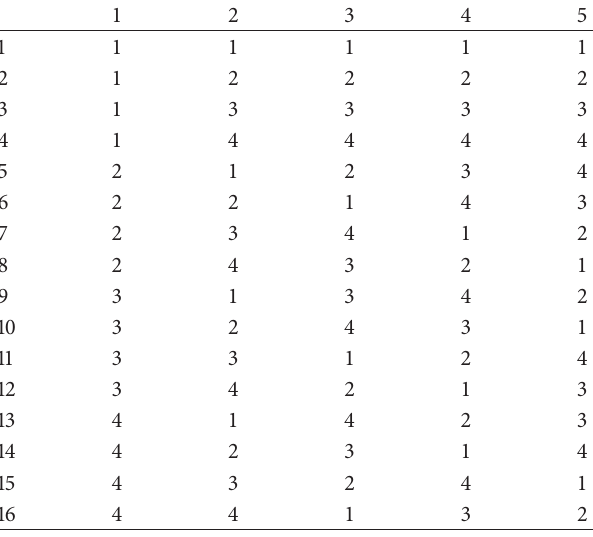
Table 4: Modified L16 orthogonal array (M16).